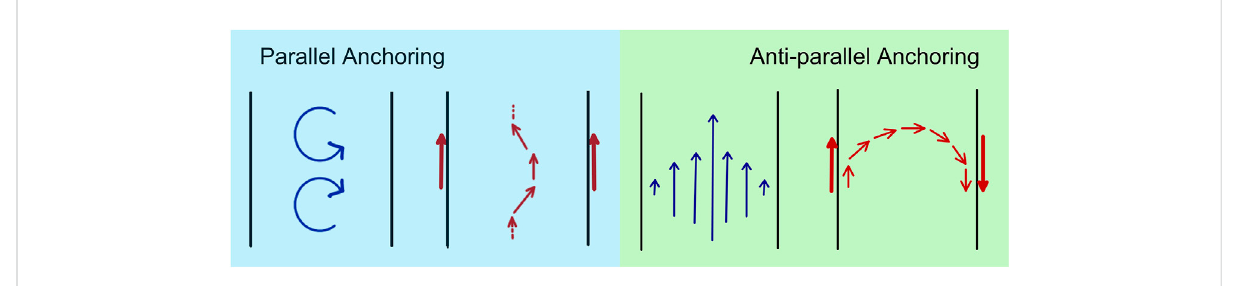
FIGURE 10 The symmetry of the boundary conditions for the polarization controls the steady fl ow states. Left frame: strong polar anchoring where the polarizationisanchored inthesame direction onbothchannelwallssuppressessplaydeformations and yieldsbend deformationalongthewall with associated fl ow vortices. Right frame: strong apolar anchoring where the polarization is anchored in opposite directions on the two walls explicitly breaks the nematic symmetry even in the absence of polar self propulsion ( v 0 = 0) and leads to coherent fl ow. Both fl ow states can occur if the boundary conditions are nematic, i.e., agnostic to the direction of the polarization